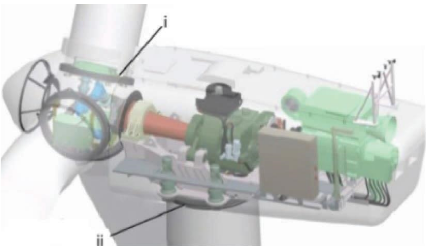
Figure 1: Fan structure with (i) pitch bearing and (ii) yaw